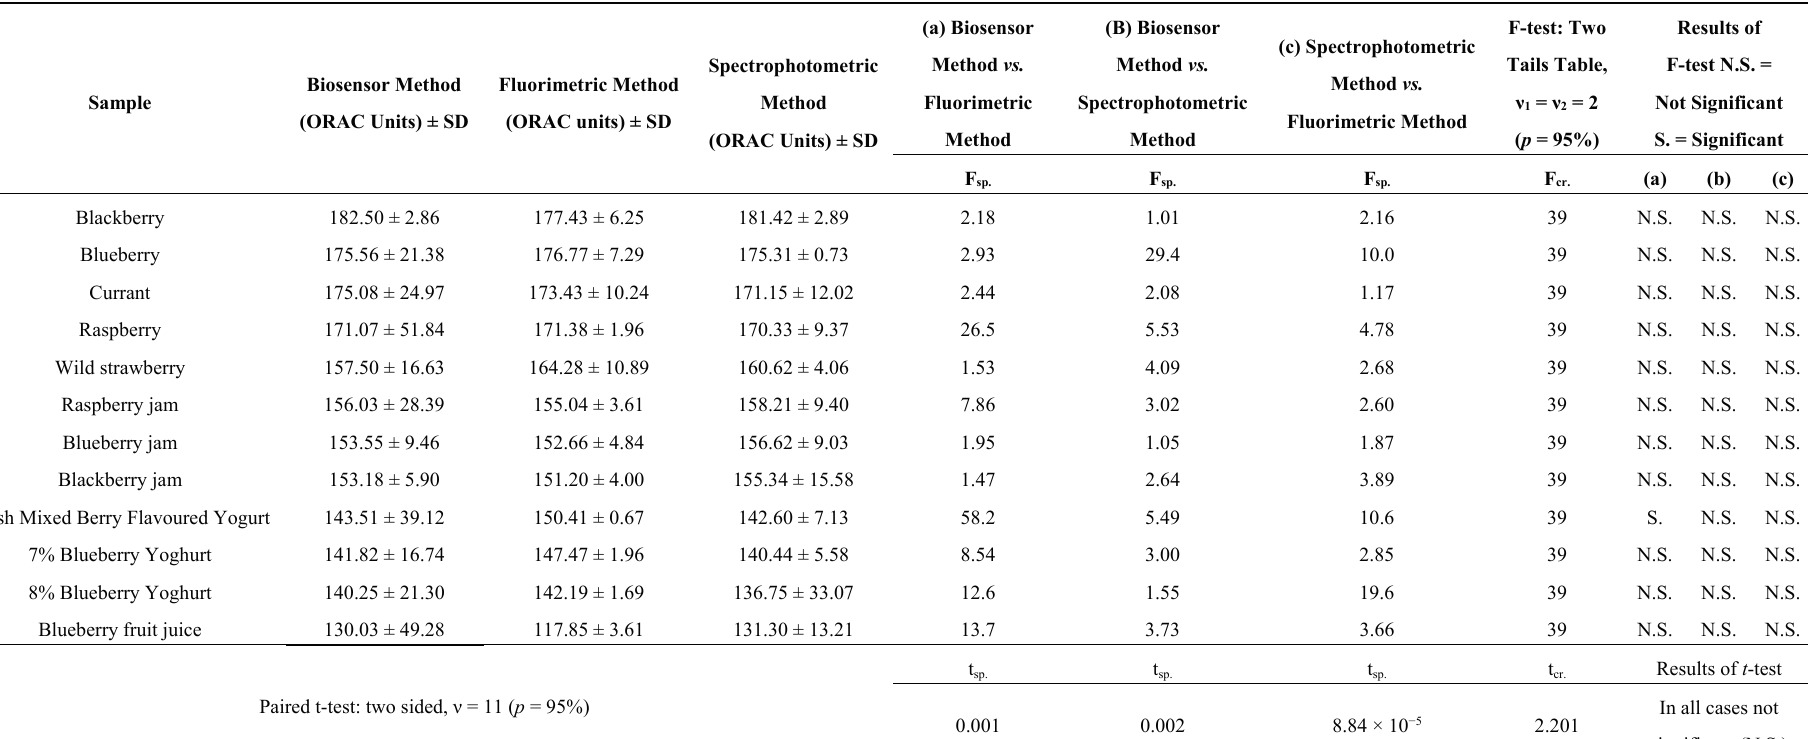
F sp. = F experimental . F cr. = F critical . t sp. = t experimental . t c r . = t critica